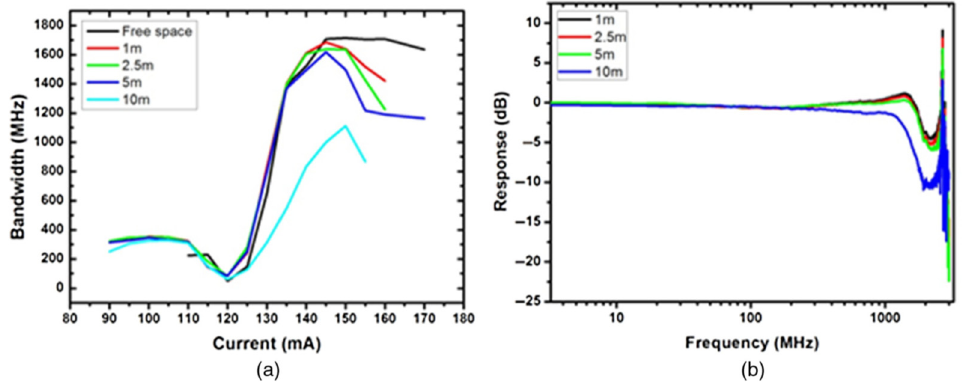
Figure 7. ( a ) Current versus bandwidth relationship for varying lengths of SI-POF and ( b ) fiber as a function of length.